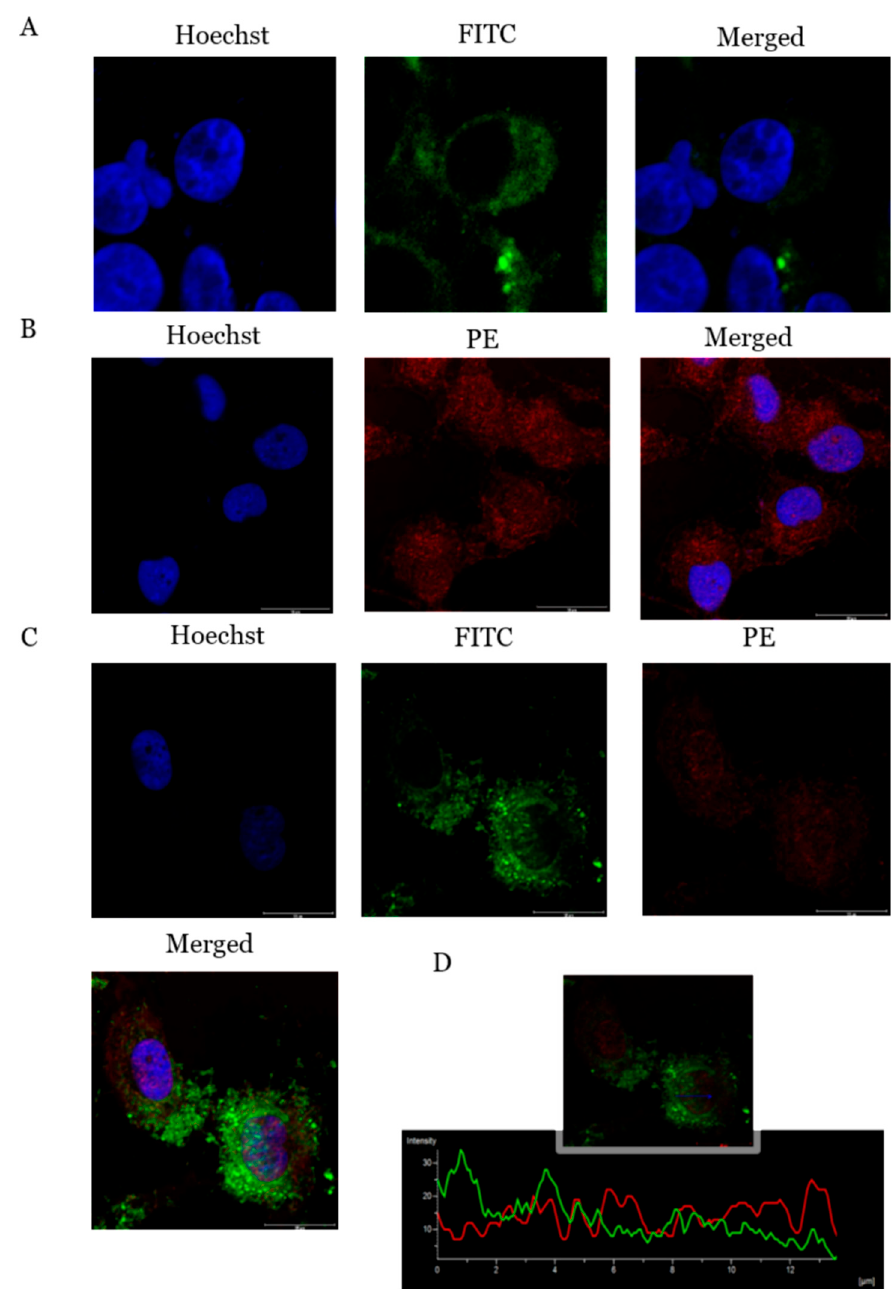
Figure 6. Immunofluorescence assays: ( A ) MDA MB231 cells stained with FITC labelled secondary antibody for ADIPOR1 (green colour) and Hoechst 33342 to stain the nuclei (blue colour). ( B ) Cells were stained with Phycoerythrin labelled secondary antibody for histidine tagged PcOSM. ( C ) C0- immunofluorescence assay for co-localization of PCOSM and ADIPOR1, cells were co stained with secondary antibodies for ADIPOR1 and PcOSM. ( D ) Intensity profile of co-localization of ADIPO-R1 and PcOSM of an area indicated in the image analysed by NIS Elements imaging